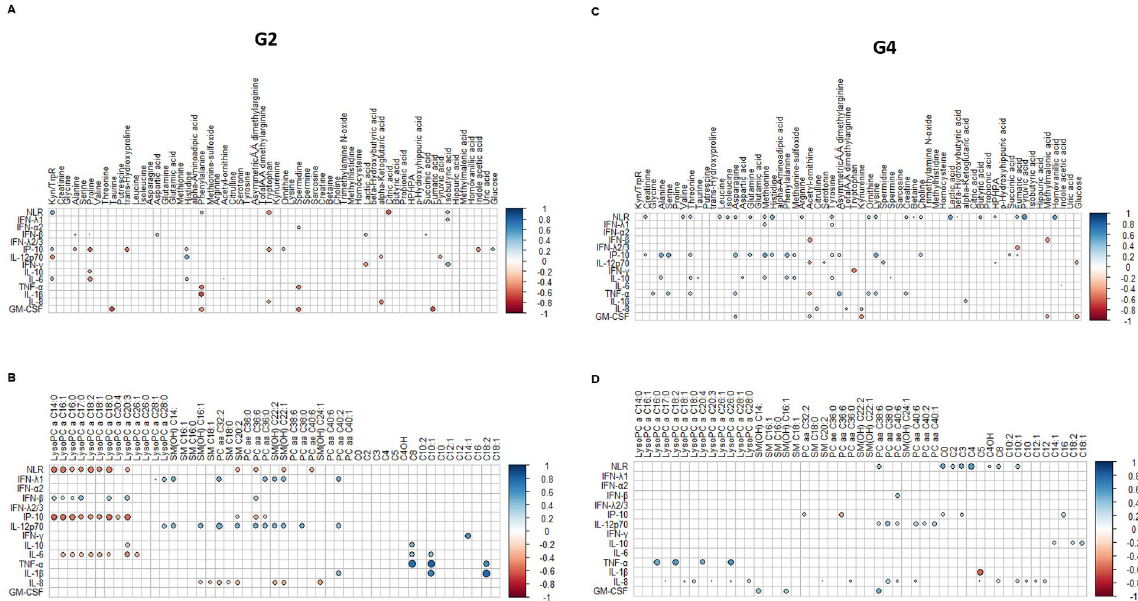
Fig 3. Patterns of correlations among all metabolites and cytokines/chemokines measured in the study. (A) Correlation between metabolites and cytokines/chemokines/ neutrophil to lymphocyte ratio (NLR) in mild patients (G2). (B) correlation between lipids and cytokines/chemokines/NLR in critically ill patients (G2). (C) correlation between metabolites and cytokines/chemokines/NLR in mild patients (G4). (D) correlation between lipids and cytokines/chemokines/NLR in critically ill patients (G4). The correlations between the concentration levels of the metabolites and cytokines and chemokines were done by Spearman’s Correlation Coefficient using the R package “corrr”, correlations plots were done using the “corrplot” package. Each analysis and plot were done in R studio (1.3.959).